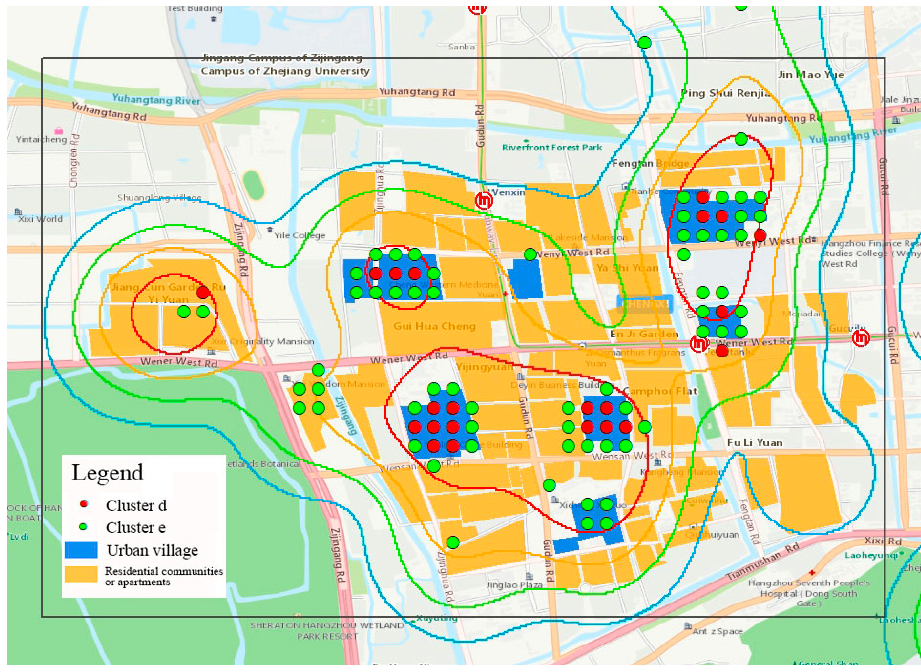
Figure 17. The distribution of clusters d and e in living hotspot region A.